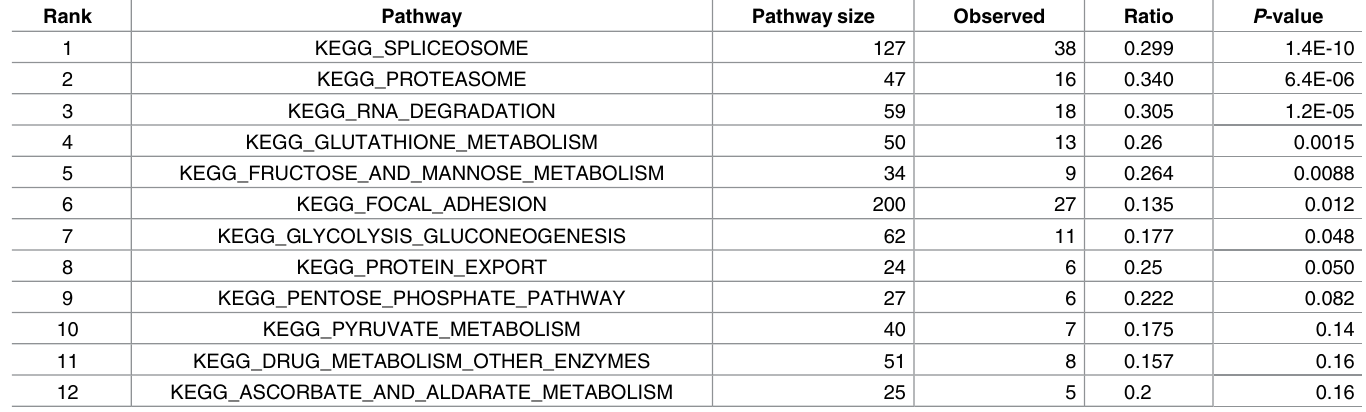
Tables 1–6 detail the categories that were significantly enriched in differentially expressed proteins corresponding to heavy carbon-ion irradiation, with proteasome pathways always ranked #1 (p-value = 2.21E-09), DNA damage response ranked #5, mRNA processing and splicing ranked #4 and #6 and cell division ranked #8 (p-value = 3.01E-6). Glycolysis/gluconeo- genesis pathways ranked #2 (BioCarta analysis, Table 3) and #7 (KEGG analysis, Table 2). Our gene set analysis revealed highly significant overlap among our top-ranked groups and previ- ously published results. For example, 13 of the 16 proteins we identified as involved in the 20S proteasome exhibited a change in expression of 1.5-fold or greater in cells irradiated at 0.2 Gy. It is not surprising that proteasome pathways ranked highest of all biological processes associ- ated with heavy carbon-ion irradiation in all gene set analyses (GO, KEGG, MIPS and Bio- Carta), with significant adjusted p-values. Although not previously closely associated with carbon-ion irradiation in any systematic manner, 38 of 127 proteins from the RNA splicing pathway (KEGG analysis) were identified as significantly regulated, corresponding to 30% of the genes in the pathway. Although a number of signaling relationships exist among ubiquitin, the cell cycle, and DNA damage, few of these proteins overlapped with either GO categories. However, using lit- erature-based annotation and network analysis, we identifieda densely interconnected network Table 2. Top-ranked pathways by KEGG